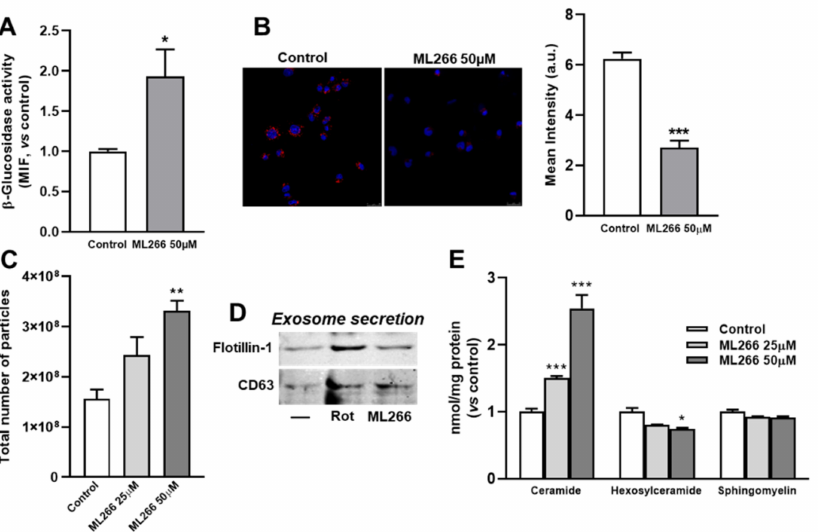
Figure 5. Effects of β -glucosidase activator on glioma C6 cells ( A ) β -glucosidase activity as analyzed by flow cytometry. Cells were incubated in LDL-supplemented medium with or without ML266 for 2 h, then the reaction substrate was added for 30 min and analyzed by flow cytometry. Results are the mean ± SEM of three independent experiments. The control is normalized to 1. MIF, median intensity of fluorescence. ( B ) C6 cells were exposed to DiI-LDL (20 µ g/mL of cholesterol) and 2.5 µ M U18666A for a total of 16 h and without (Control) or with ML266 (50 µ M) for the last 4 h. The cells were fixed and analyzed by confocal microscopy. The images show DiI-LDL in red and nuclei labeled with Hoechst-33342 in blue. Representative results from three independent experiments are shown. Scale bars = 25 µ m. The graph shows quantitative results of DiI-LDL labeling (mean intensity, a.u.) in cells of each photomicrograph. Results are the mean ± SEM of three independent experiments, with 8 − 10 photographs per experiment. ( C ) Total particle secretion analyzed by nanoparticle tracking. The experiments started with the same number of cells. Cells were exposed to LDL (60 µ g/mL of cholesterol) in the presence of 2.5 µ M U18666A for 12 h. The medium was then removed, the cells washed twice, and serum-free medium was added, supplemented with U18666A, then incubation was continued for 4 h in the presence of 50 µ M ML266 or 5 µ M rottlerin (Rot). At the end of the incubation, the medium was removed, and the exosomes/microvesicles were isolated and analyzed. The mean ± SEM of three measures are shown. ( D ) Western blot of flotillin-1 and CD63 in secreted particles. Results are representative of three independent experiments. ( E ) Sphingolipids cell